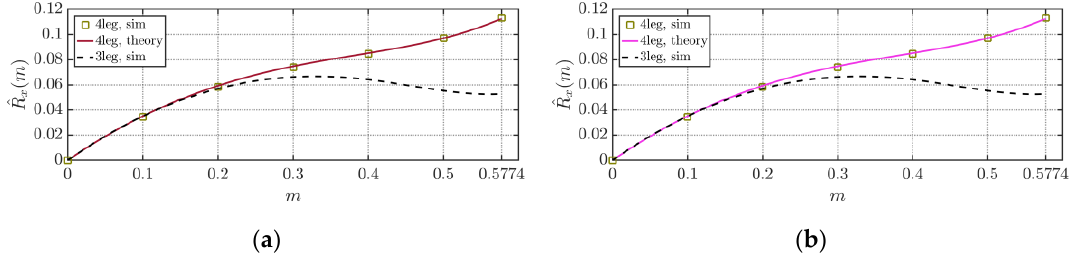
Figure 21. Normalized current ripple rms as a function of m for: ( a ) DPWM0; ( b ) DPWM2.